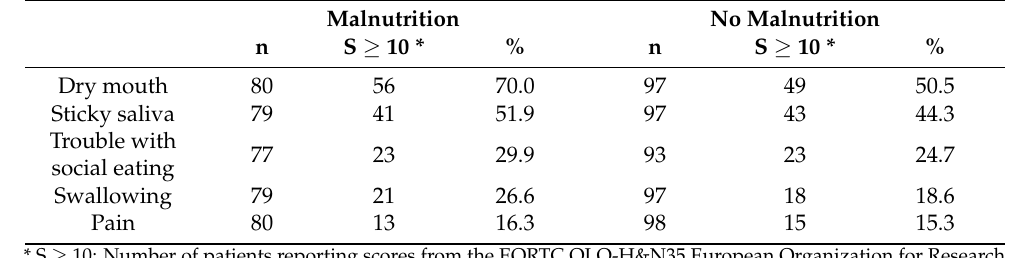
Table A2. Clinically relevant deterioration from the start of treatment to one year after the termination of treatment in a number of EORTC QLQ-H&N35 scales proven to be significantly different between patients with malnutrition defined by the Global Leadership Initiative on Malnutrition (GLIM) and patients without malnutrition. Malnutrition No Malnutrition n S ≥ 10 * % n S ≥ 10 * Dry mouth 80